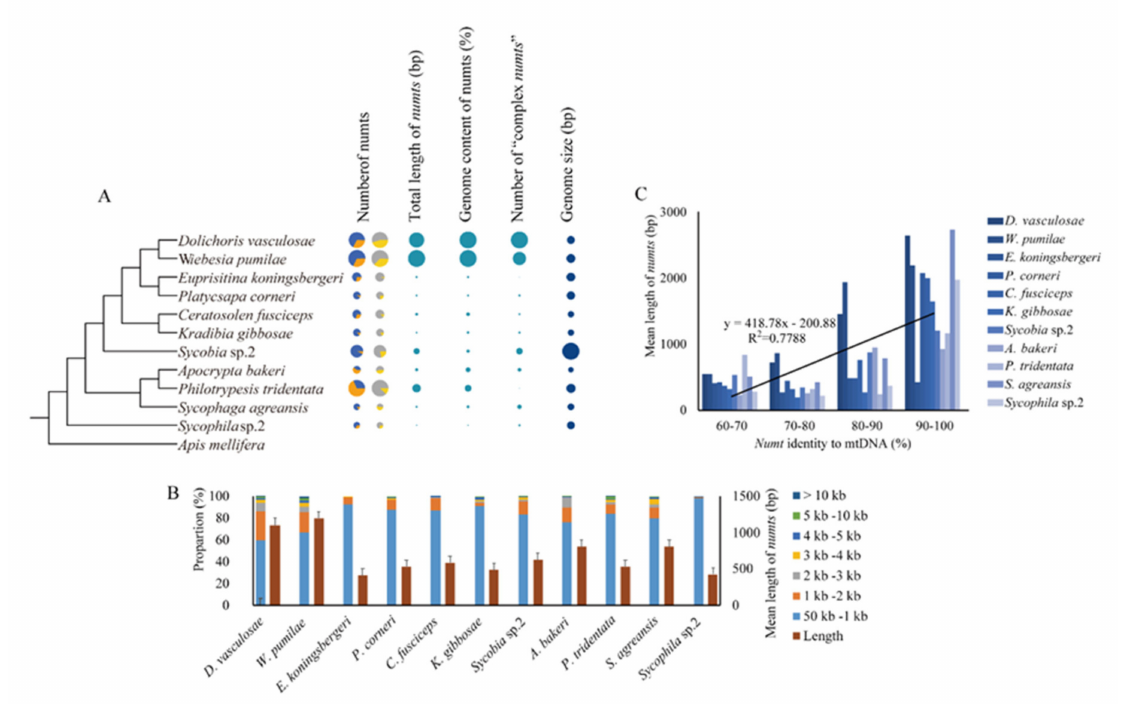
Figure 1. Distribution of nuclear mitochondrial DNA sequences (NUMTs) in fig wasp genomes. ( A ) The number of NUMTs in the fig wasps. The phylogenetic tree on the left was obtained from our unpublished phylogenomic work [36], and the pie chart columns on the right display the statistical results of the NUMTs. The size of the pie chart corresponds to the number of data in each group. In the result group of “Number of NUMTs”, the pie chart in the first column shows the content of “duplicate type” NUMTs (orange) and “insertion type” NUMTs (blue), while the second column shows the content of NUMTs contained in “complex NUMTs” (yellow) compared to others (grey). ( B ) The length distribution of NUMTs. Each species had two columns, with the left one representing the proportion of NUMTs in di ff erent length ranges (corresponding to values on the left vertical axis) and the right one representing the mean length of NUMTs in the species (corresponding to the values on the right vertical axis). ( C ) The correlation between NUMT length and the sequence divergence of NUMTs from their corresponding mtDNAs. For each species, the average lengths of NUMTs of di ff erent ranges of similarity with their mtDNA are shown, and in general, the higher the similarity to the corresponding mtDNA, the longer the average NUMT